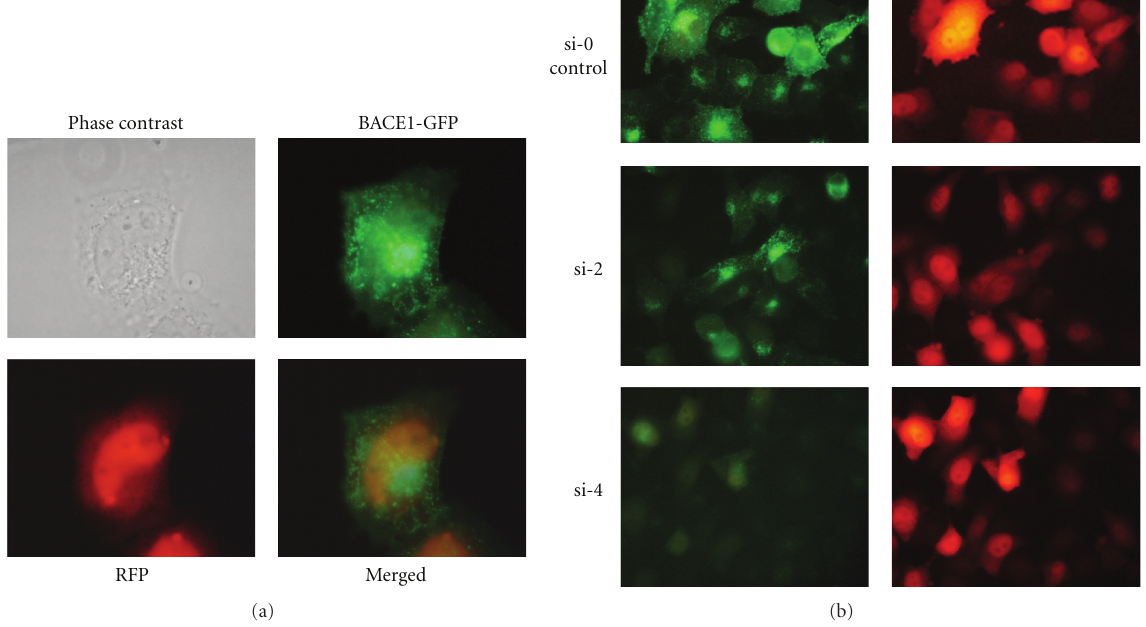
Figure 1: Expression of pBACE-GFP/pDsRed2-N1 plasmids in HeLa cells (a) and silencing e ff ect of selected siRNAs in these cells (b).